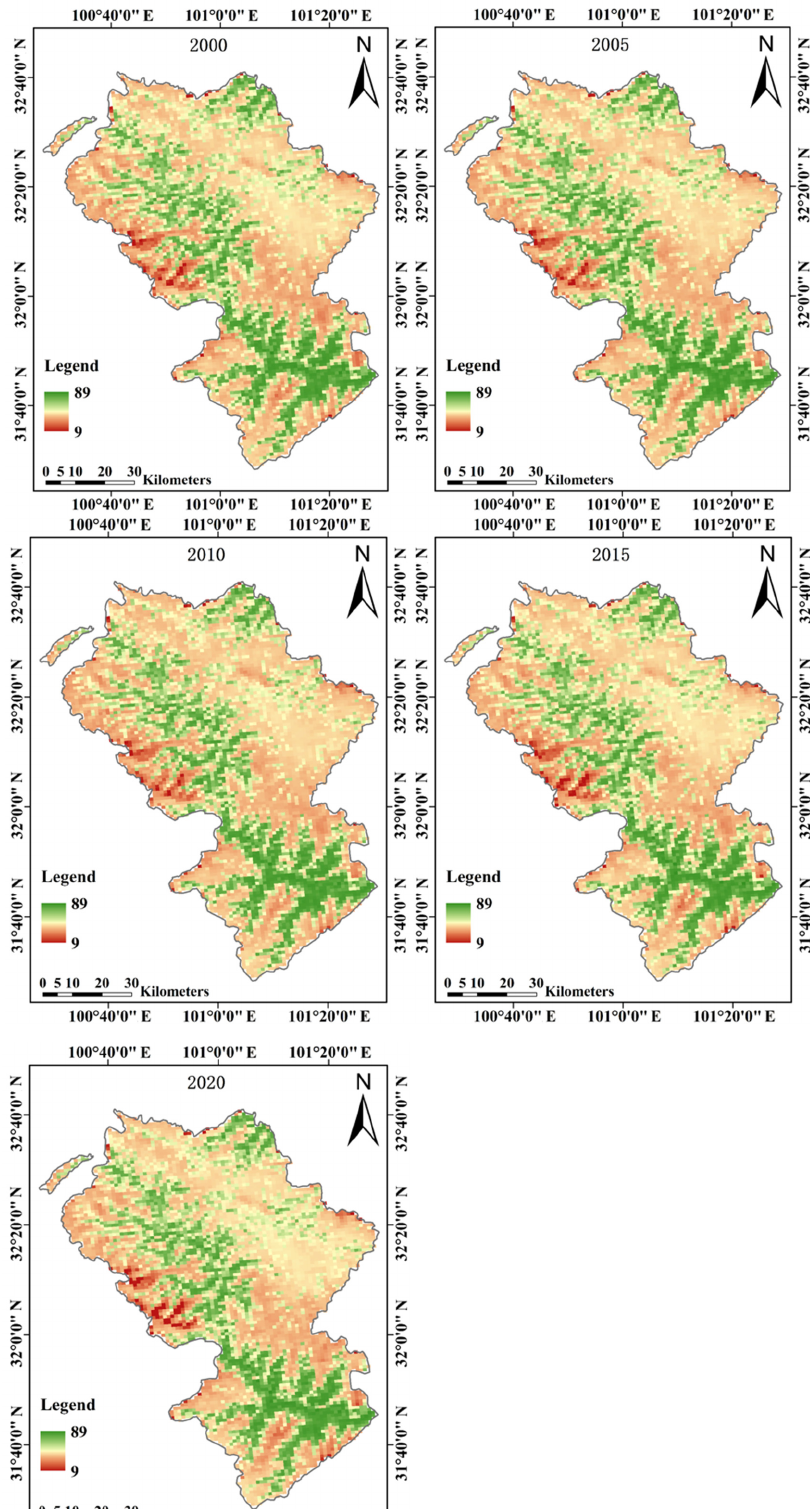
Figure 14. Land stress index of Rangtang County. Table 10. Value of EI in Rangtang County.